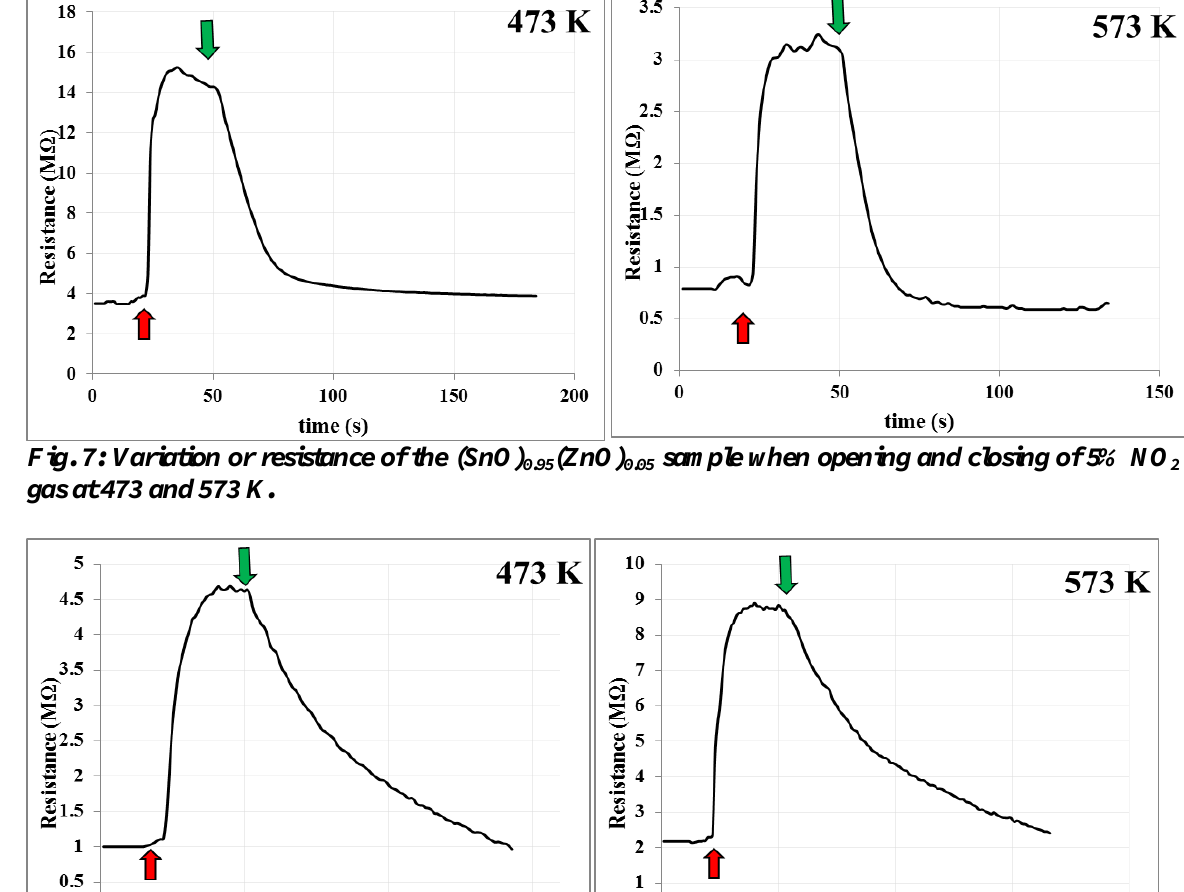
Fig.6: Variation of resistance of the SnO 573 K.